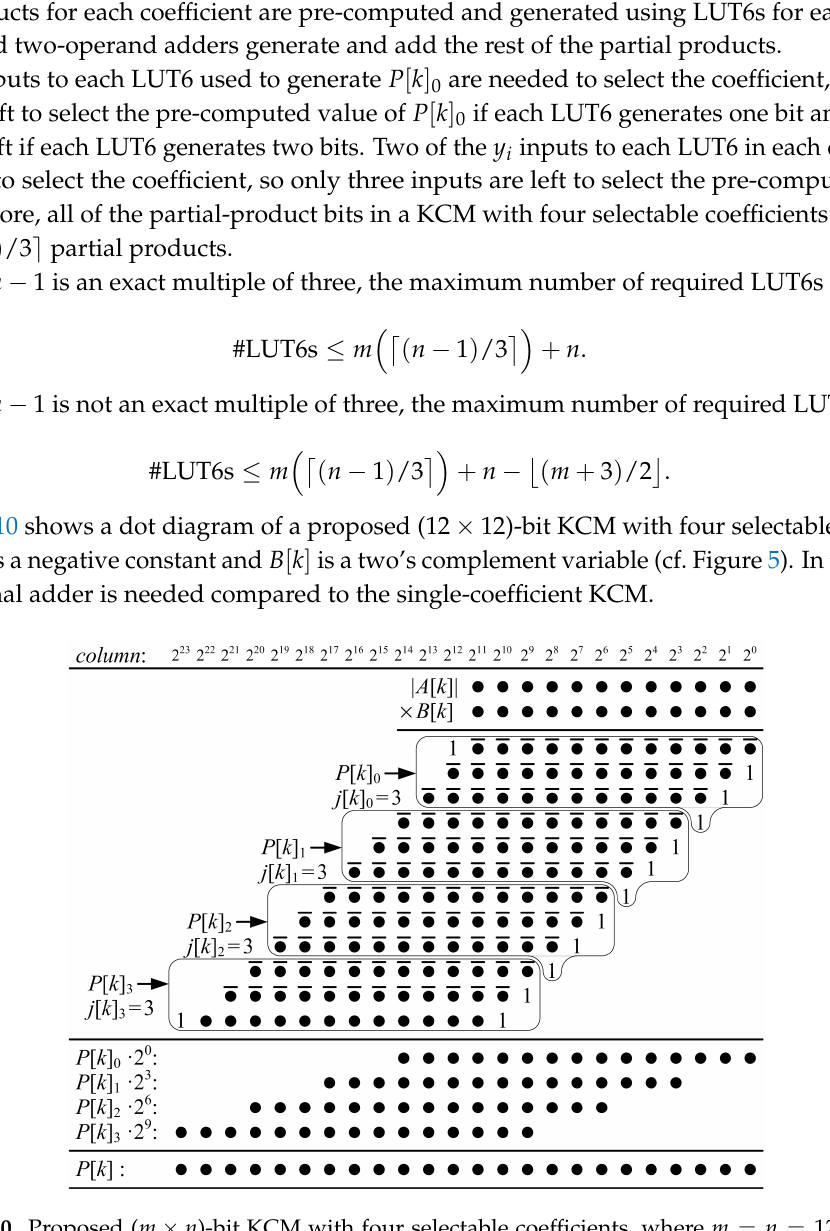
Figure 10. Proposed ( m × n )-bit KCM with four selectable coefficients, where m = n = 12, A [ k ] is a negative constant and B [ k ] is a signed variable). This example requires approximately 33% more LUTs and one extra stage if pipelined compared to a (12 × 12)-bit KCM with a single